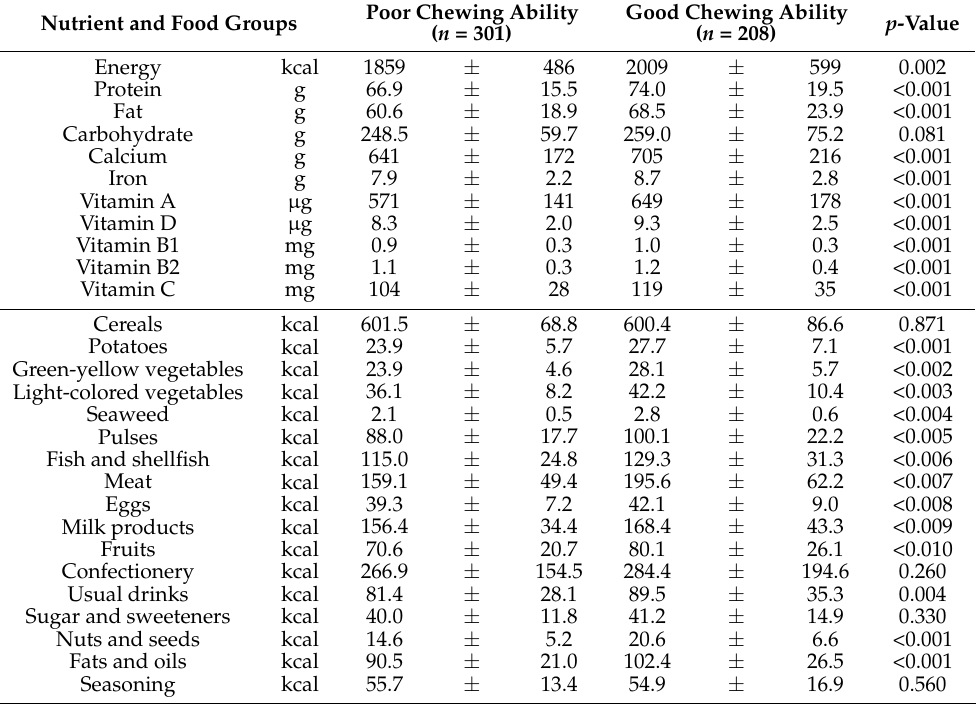
Table 2. Nutrient and food groups intake compared to chewing ability.